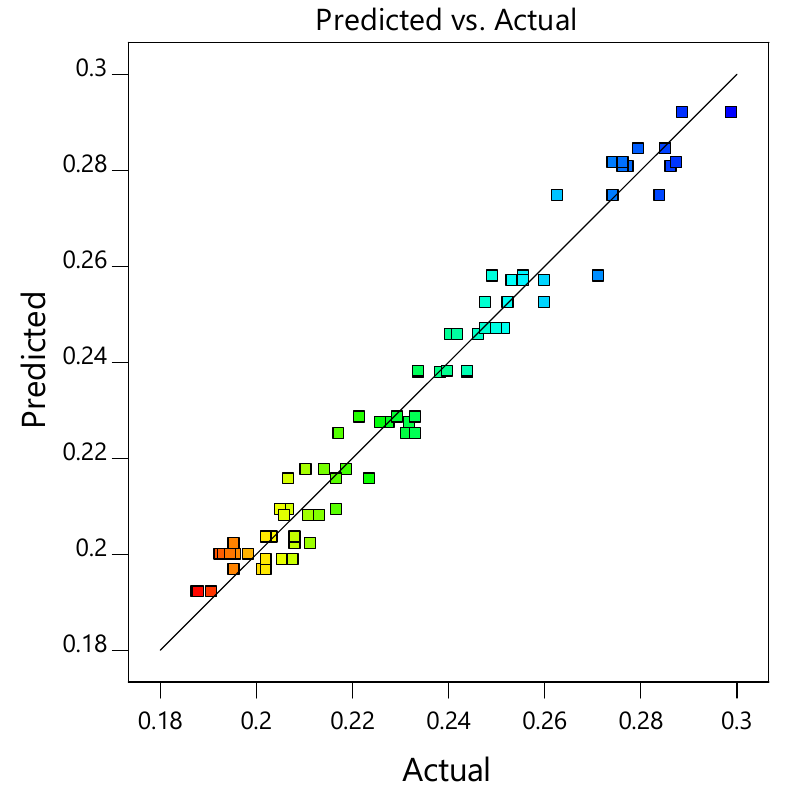
Figure 4. Surface response plot for predicted vs. actual values. The concentration of the data points near the straight line shows high correlation, and adequate precision. The blue color represents the minimum value, whereas the red color represents the maximum value. The rest of the color represents a range between the colors red, and blue. Each square represents the experimental value obtained from the runs.